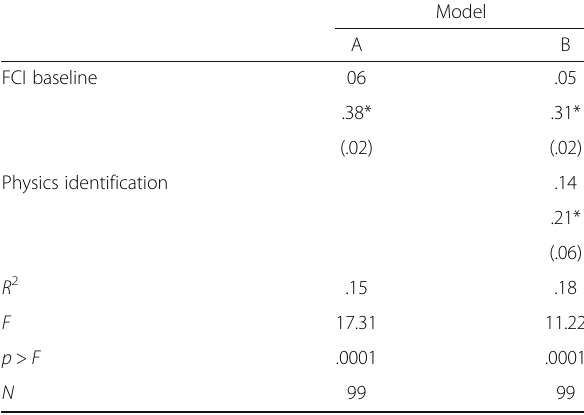
Table 4 Regression models for physics identification on